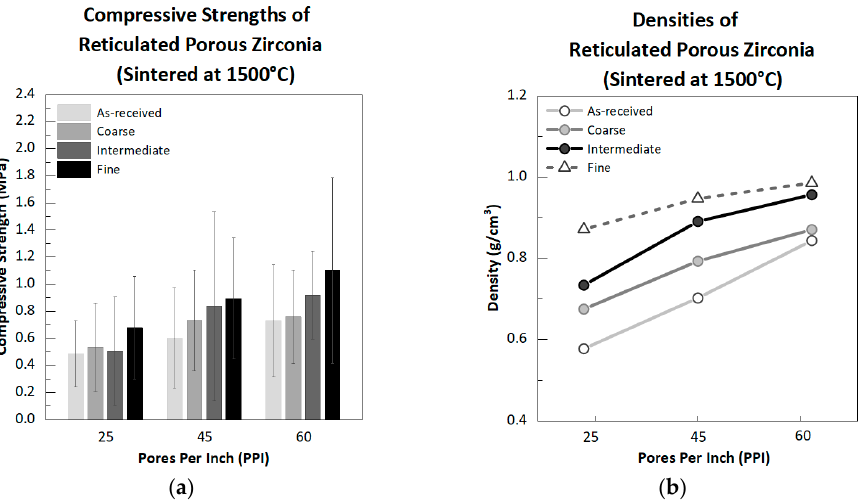
Figure 10. ( a ) Compressive strength outcomes of the reticulated porous zirconia prepared from the as-received, coarse, intermediate, and fine zirconia particles when sintered at 1500 °C, and ( b ) the corresponding density levels